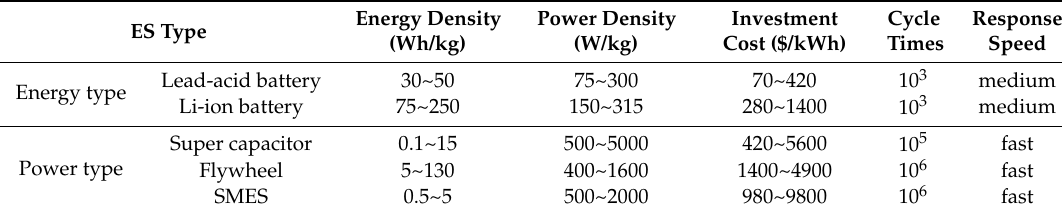
Table 1. Parameters of various types of energy storage (ES) devices.